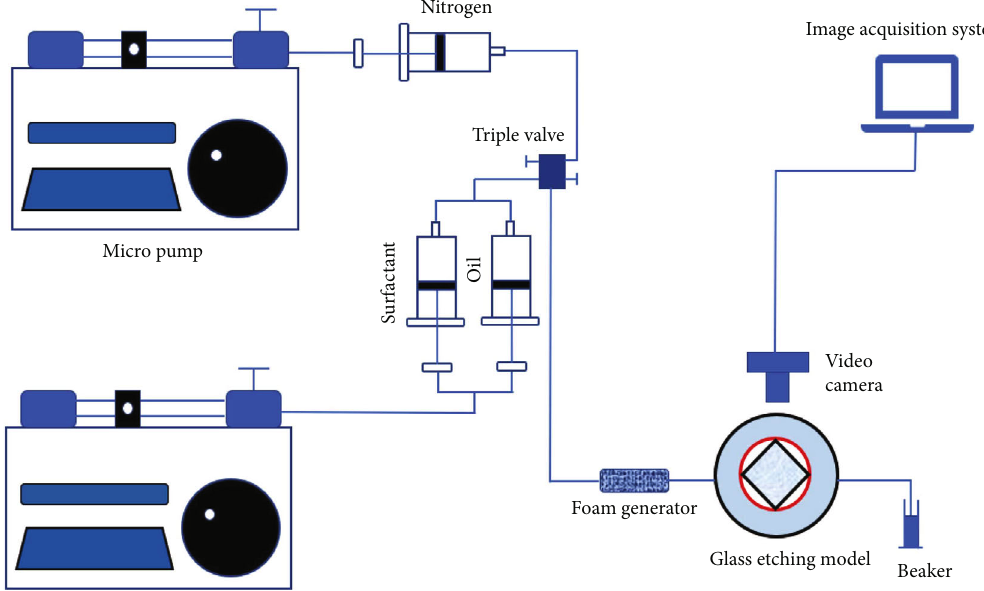
Figure 2: Flow chart of the microscopic visualization experiment